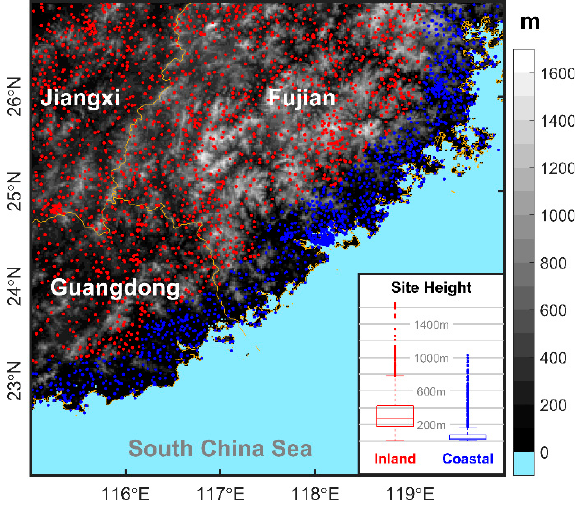
Figure 1. Topography map and distribution of rain gauges over southeastern China. Topography height is shaded (unit: m) and the inland and coastal rain gauges are scattered in red and blue dots, respectively. A coastal (inland) rain gauge is defined if the minimum distance between the site and coastline is smaller than (equal or large than) 40 km. The provincial boundaries are denoted by yellow curves. The boxplots showing the site height distribution of the two kinds of rain gauges are given on the bottom right. For each boxplot, the top and bottom edges of the box denote the upper and lower quartiles ( q 3 and q 1 ), respectively. The line inside the box denotes the median. The sample outliers, denoted by dots, are the values larger than q 3 + 1.5× ( q 3 − q 1 ) or smaller than q 1 − 1.5× ( q 3 − q 1 ). The whiskers above and below each box represent the nonoutlier maximum and minimum, respectively.